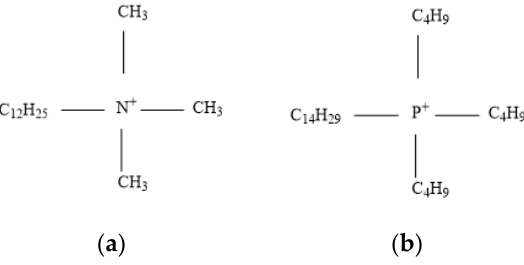
Figure 1. Schematic diagram of chemical structures of the dodecyl triethyl ammonium chloride (DTA + ) ( a ) and tributyltetradecyl-phosphonium chloride (TTP + ) ( b ).